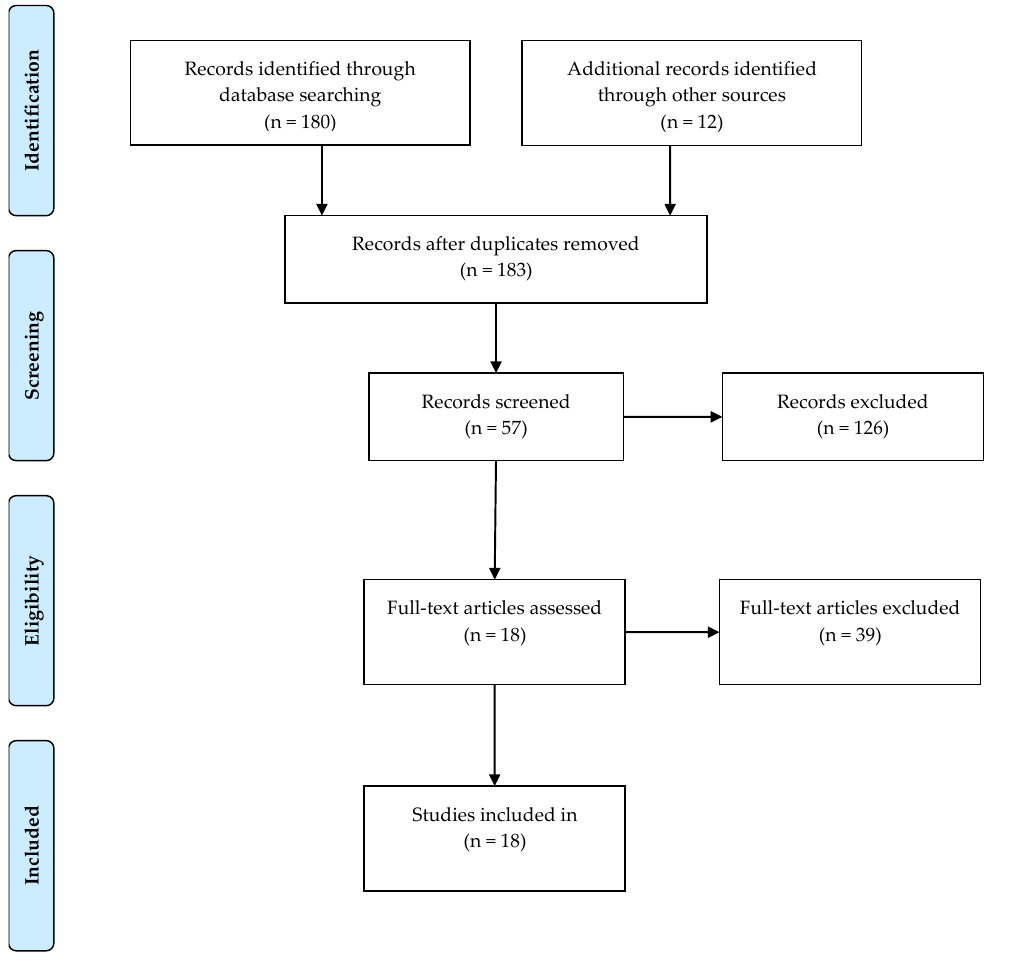
Figure 1. Work’s PRISMA flow.